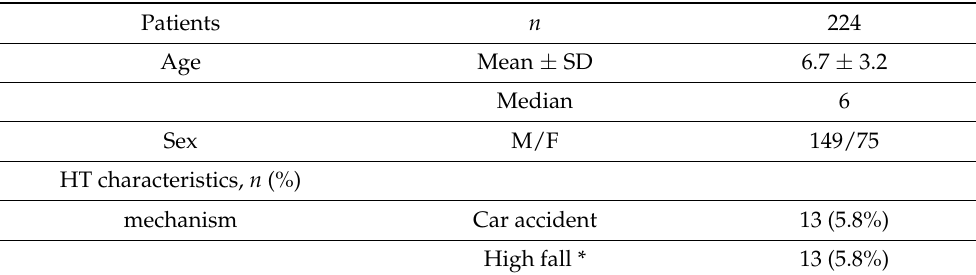
Table 1. Characteristics of 224 pediatric patients referred to the pediatric emergency department (PED) for minor head trauma (MHT). Instability or dizziness were considered when persistent regardless of headache attacks. In the case of gait instability, orthopedic injuries were ruled out by physical and/or radiological examination. Amnesia includes loss of memory of the events both preceding and following MHT. * fall from >1.5 m; ** fall from <1.5 m; ◦ listed further in the same column. CT: computer tomography; SD: standard